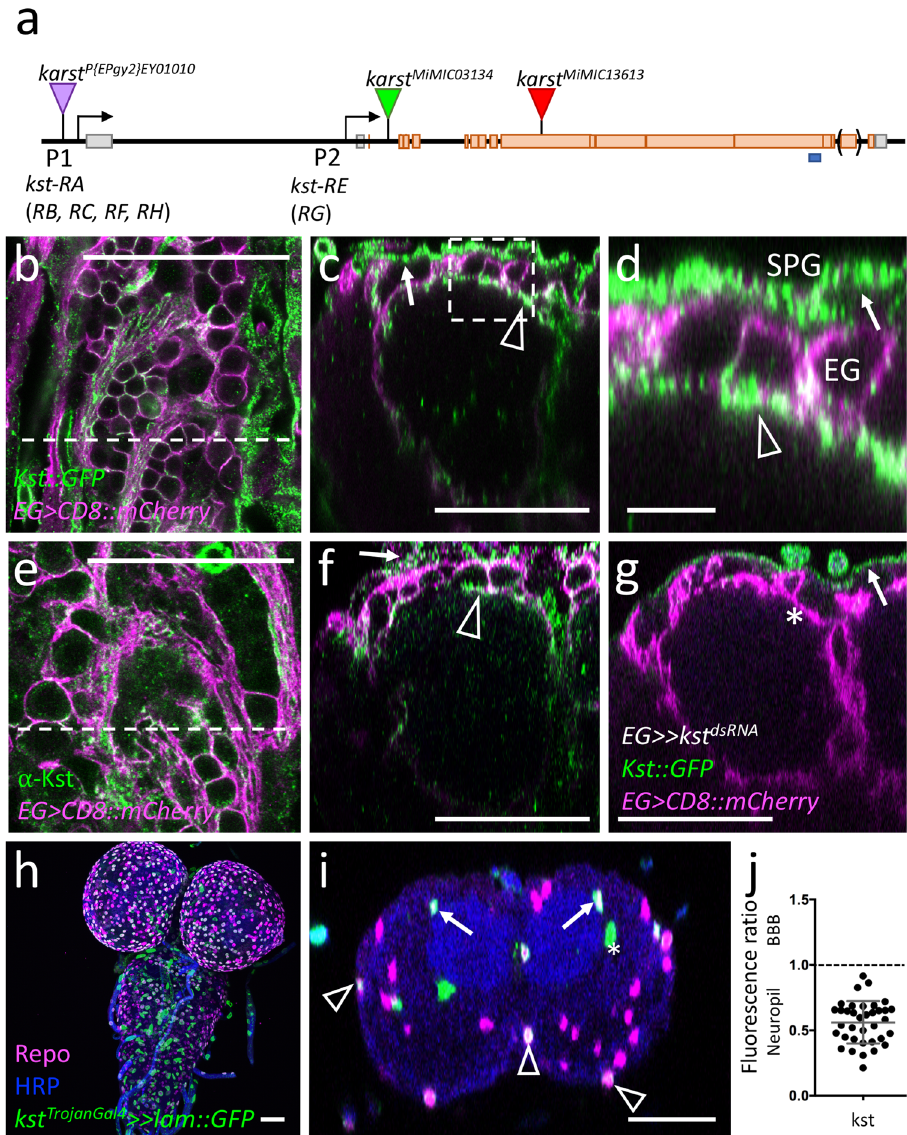
Fig. 8 ß H -Spectrin shows a polar distribution in ensheathing glia. Representative images are shown. a Schematic view of the karst locus. Transcription is from left to right. Seven different karst mRNAs are generated from two promoters (P1, P2) as indicated ( kst-RA - RH ). The ß H -Spectrin proteins PE and PG differ in a C-terminal exon indicated by brackets. The position of two MiMIC insertions and the EP insertion used for gain of function experiments is indicated, the blues line denotes the position of the peptide used for immunization. b Confocal view of the surface of a third larval instar brain of a kst MiMIC03134::GFP animal that expresses mCherry in all ensheathing glia [ 83E12-Gal4, UAS-CD8::mCherry ]. The dashed line indicates the position of the orthogonal view shown in ( c , d ). Expression at the blood – brain barrier forming subperineurial glia (arrows) and at the apical domain of the ensheathing glia (arrowheads) can be detected. For quanti fi cation see ( k ). e Similar view as shown in ( b ) of a control larva stained for Kst expression using a polyclonal antiserum. The dashed line indicates the position of the orthogonal view shown in ( f ). f Localization of Kst protein is weakly seen in the blood – brain barrier (arrow) and the ensheathing glia (arrowhead). g Orthogonal view of a kst MiMIC03134::GFP animal expressing kst dsRNA in the ensheathing glia (EG) [ 83E12- Gal4, UAS-kst dsRNA ]. Expression of Karst in ensheathing glia cannot be detected anymore (asterisk). Expression in the blood – brain barrier is unaffected (arrow). h , i The Trojan Gal4 element in kst MiMIC03134 directs Gal4 expression in the kst P2 pattern. Lamin::GFP localizes to ensheathing glial nuclei (arrows), some cells of the blood – brain barrier (arrowheads) and some cells in the position of tracheal cells (asterisks). j Quanti fi cation of Karst localization in different membrane domains of ensheathing glial cells, quanti fi cation as described in Fig. 6. Scale bars are 50 µ m except d : 10 µ m. Source data are provided as a Source Data fi